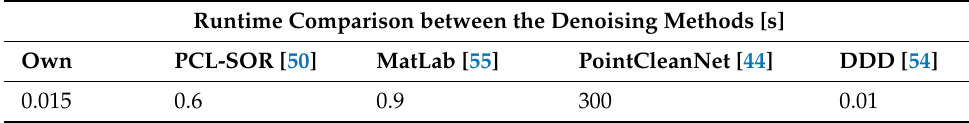
Table 5. Summary of the filtering runtime comparison with other